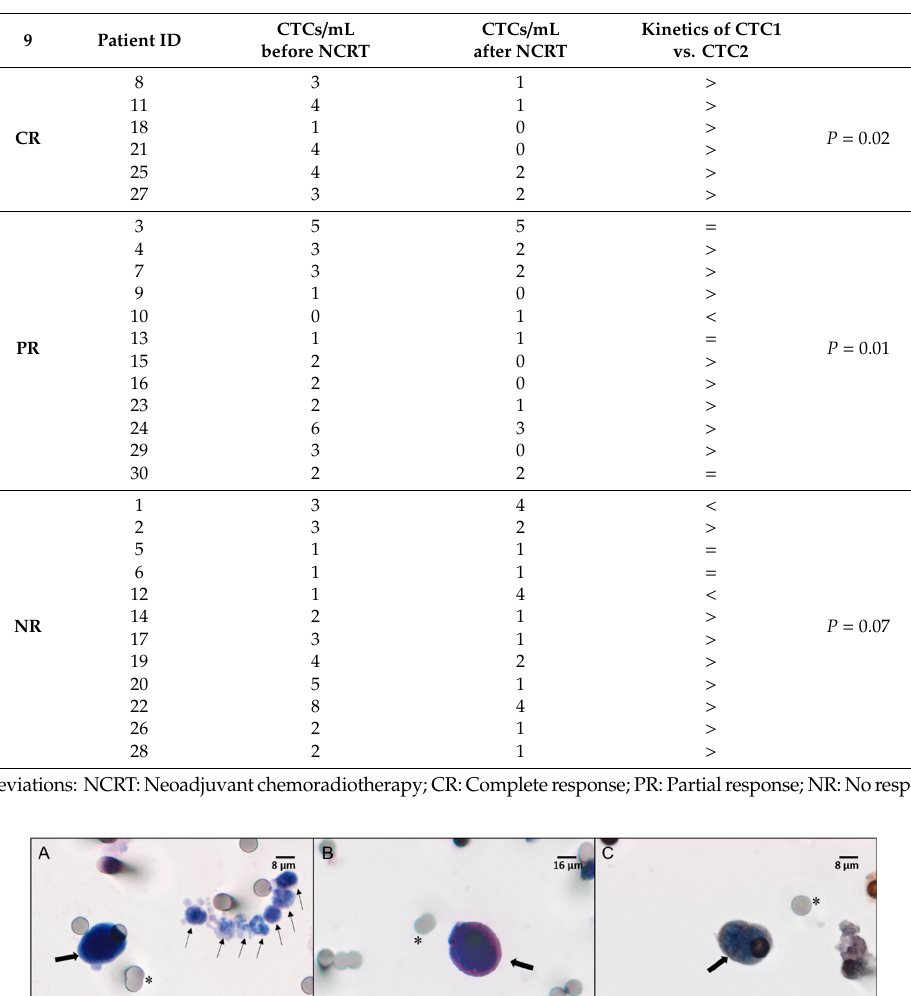
Table 2. Kinetic counts of circulating tumor cells (CTCs) between baseline (CTC1) and post-neoadjuvant chemoradiation (NCRT) (CTC2) time points.